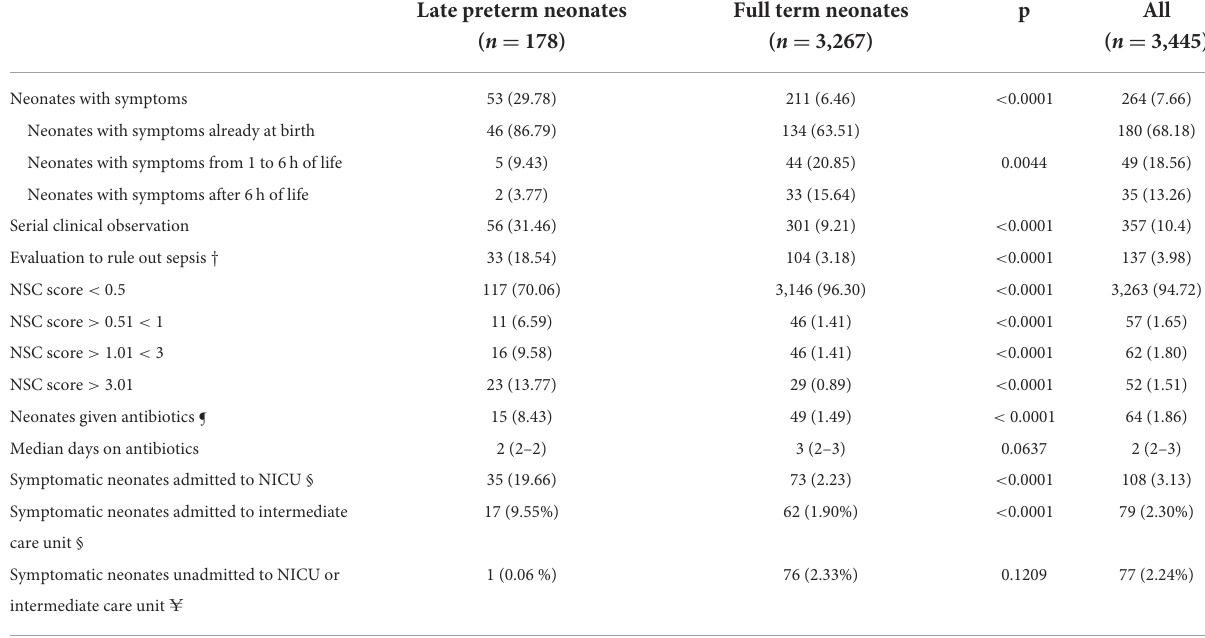
TABLE 3 Age at presentation of symptoms, NSC score and